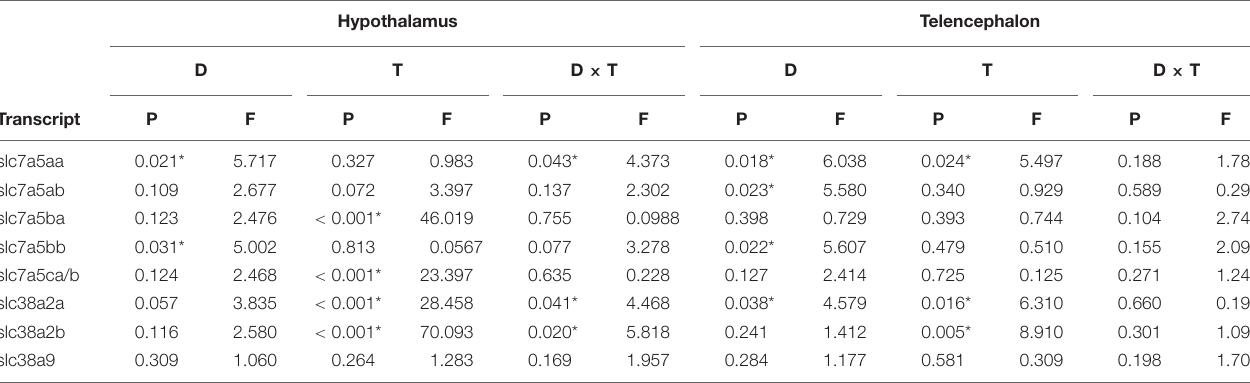
FIGURE 3 | Unrooted phylogenetic tree depicting the evolutionary relationships of Atlantic salmon Slc38a9-type transporters in the context of the evolutionary relationships of Salmoniformes and Esociformes. See legend of Figure 1 for further details. TABLE 5 | P and F -values obtained after two-way analysis of variance of parameters assessed in hypothalamus and telencephalon of rainbow trout. Diet (D) and Time (T) were the main factors, and Diet × Time (D × T) is the first order interaction.